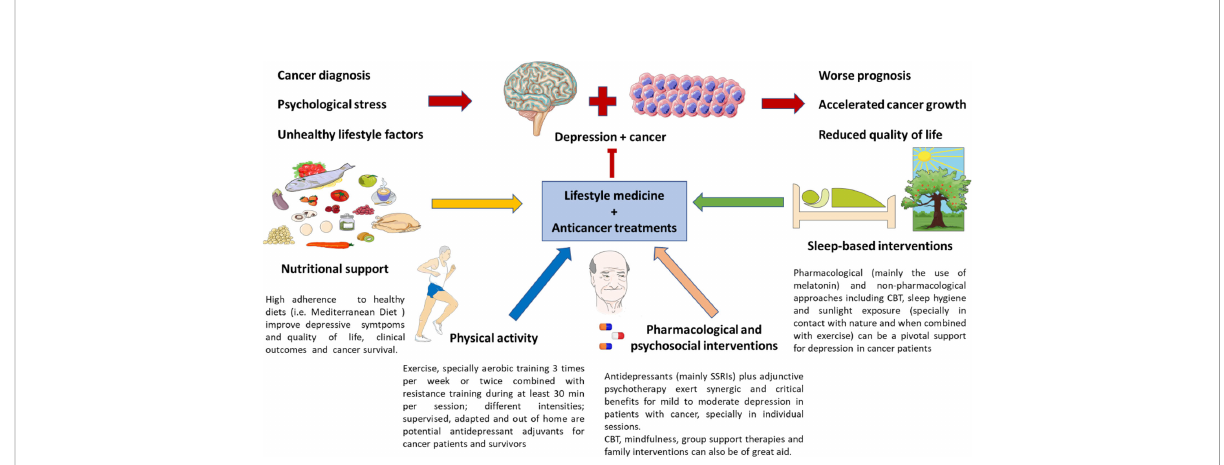
FIGURE 2 Lifestyle medicine in the clinical management of depression in patients with cancer. As previously mentioned, due to the proper diagnosis of cancer and its emotional impact, psychological stress, and unhealthy habits, patients with cancer can suffer from depressive disorders, which are related to a poorer prognosis, accelerated cancer growth, and a reduced quality of life. Nutritional support, together with encouraging physical activity, psychosocial plus pharmacological adjuvants and sleep-based interventions are critical for preventing and ameliorating depressive symptoms in cancer patients. However, it cannot be denied that some of these measures are not easy to implement in this population. Thus, the main evidence collected up to date in each fi eld is brie fl y exposed in this